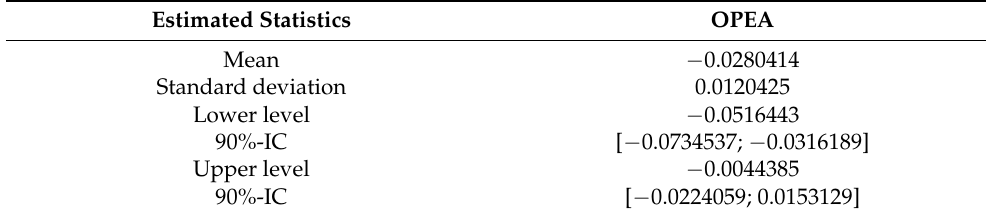
Table 3. The OPEA reference distribution and interval in the SHeS sample of healthy adults (N = 220). Estimated